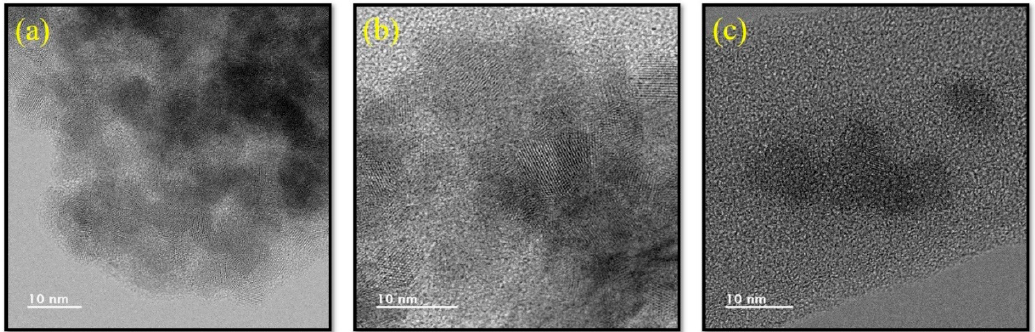
Figure 3. TEM images of pure CdS ( a ), Cd 0.9 Zn 0.1 S ( b ) and ( c ) Cd 0.8 Zn 0.2 S solid solutions.